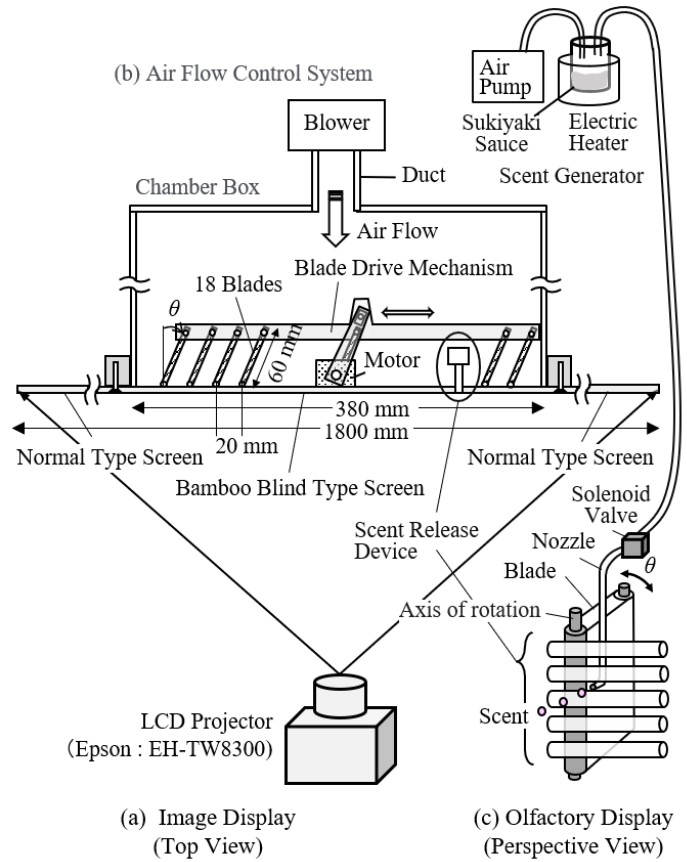
Figure 1. Device configuration of KMMD using a bamboo blind-type screen.